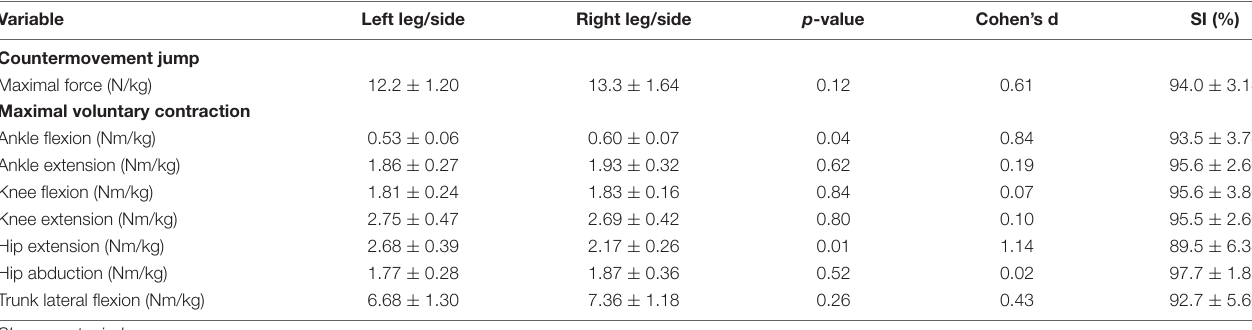
TABLE 1 | The values (means ± standard deviations, statistical comparison of the right and left legs) of the parameters measured and corresponding motor symmetry indices (independent variables).